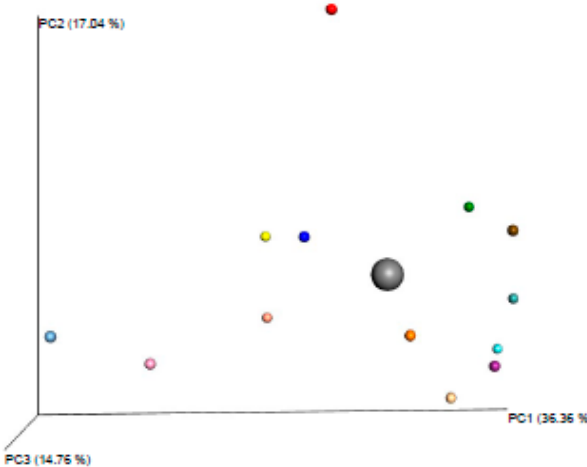
samples do not share any species. Numbers represent animals. TE+: Taylorella equigenitalis carrier. * group of samples with p < 0.1.